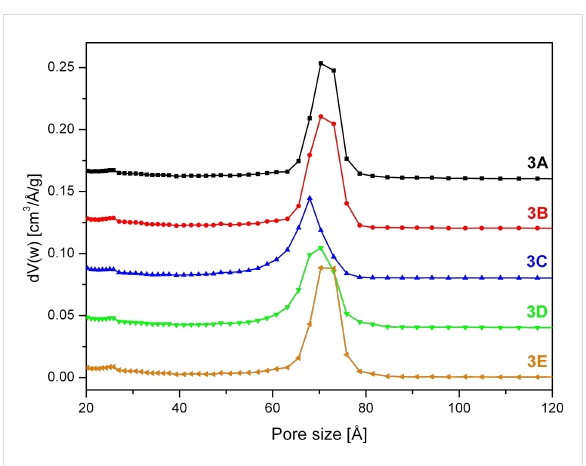
SBA-15 sample 2C . Also the lattice constant a 0 (Table 1) of sample 2C is reduced by 9 Å compared to sample 2B , showing